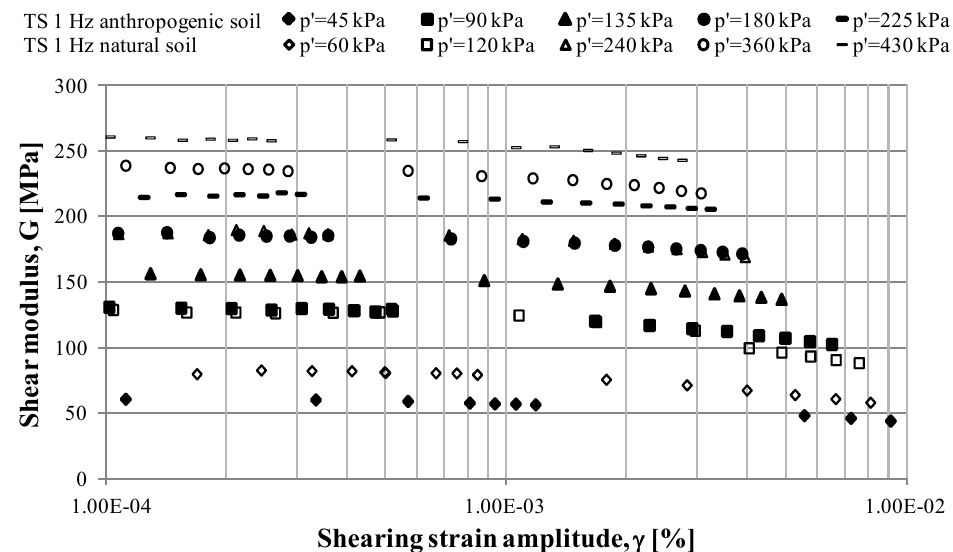
Fig. 12. Comparison of shear modulus of anthropogenic soil tested with natural soil from Sas et al.